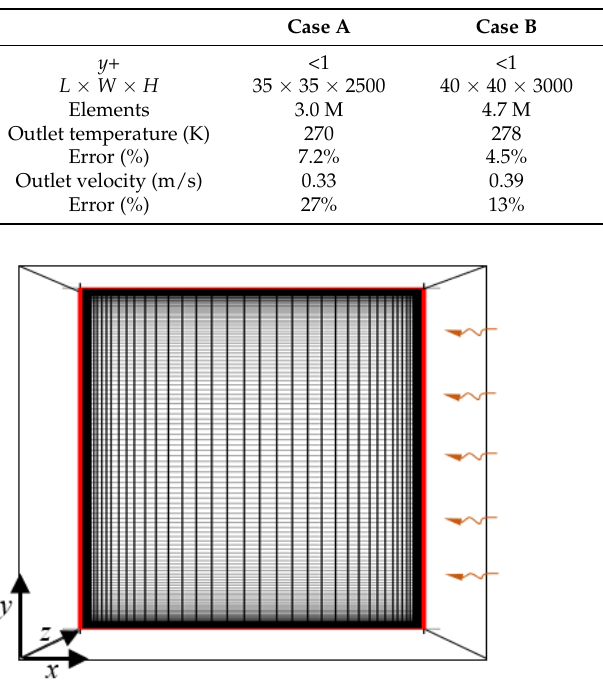
Table 4. Mesh validation for the four grid systems.